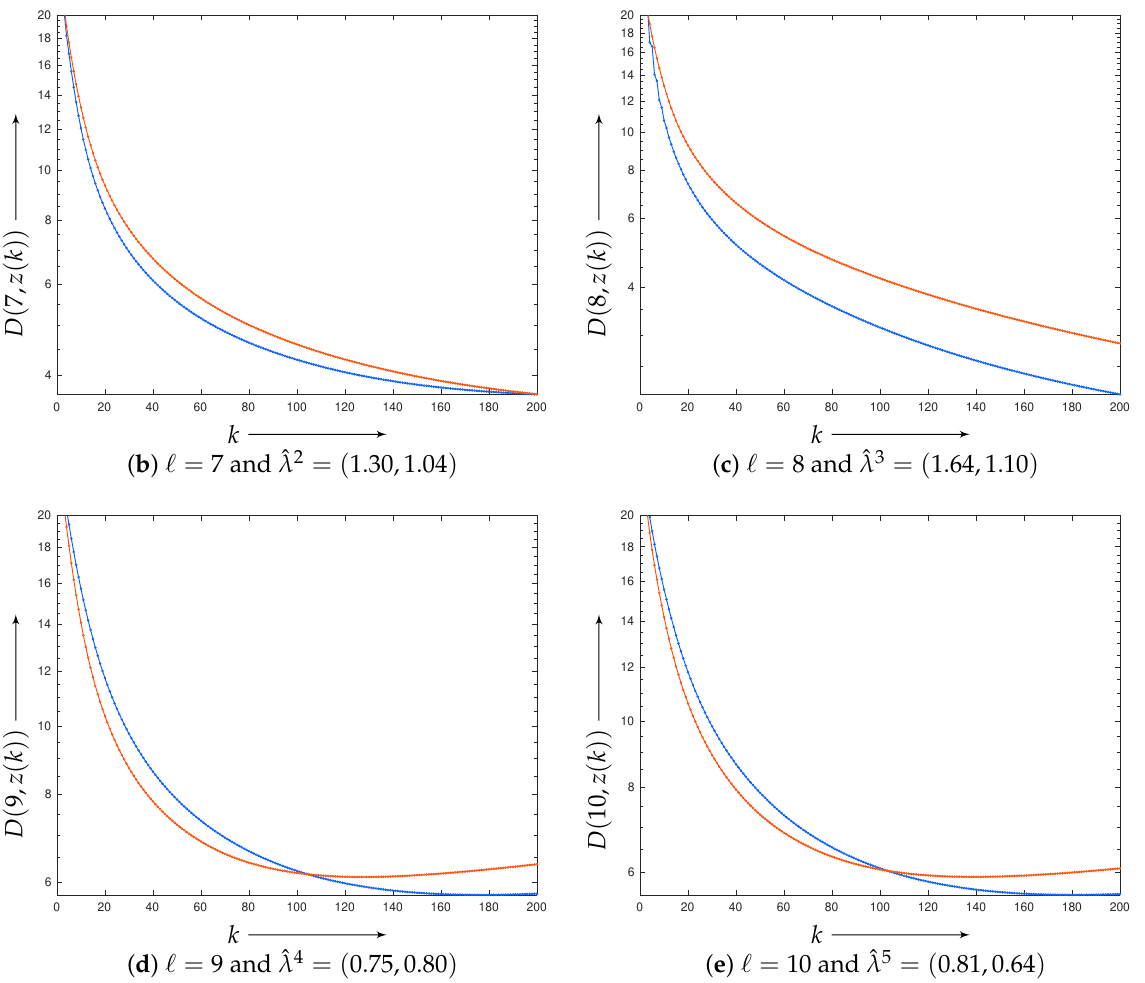
Figure 13. Evaluation function values of z ( k ) with projection y (cid:96) for any k . Blue and red points are for parameters λ = ˆ λ (cid:96) − 5 and ( 1,1 ) , respectively.